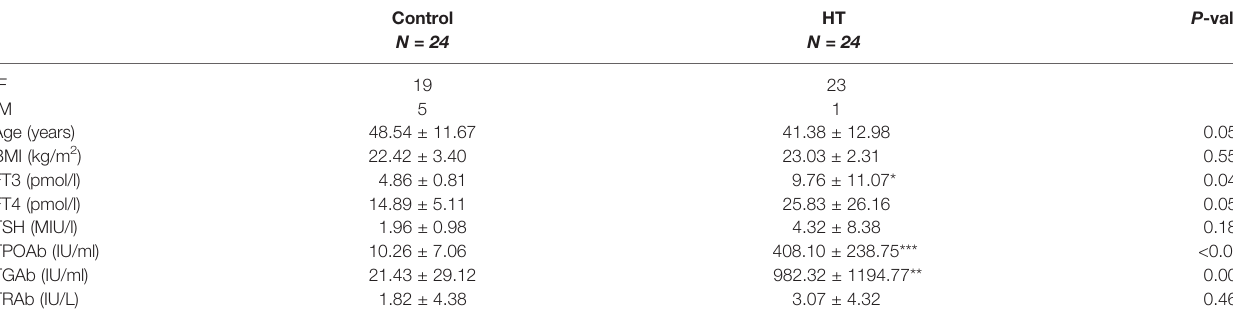
TABLE 1 | Clinical characteristics of HT samples.